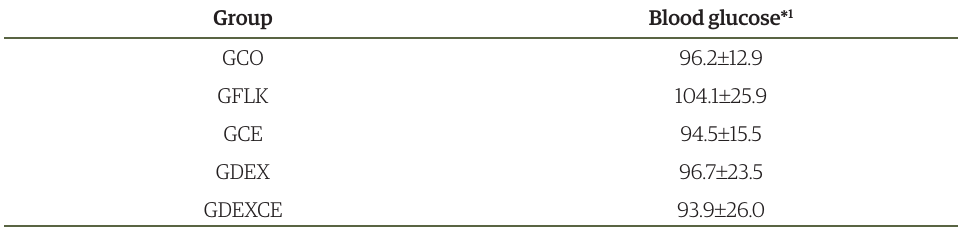
Table 6. Blood glucose values (mg/dL) in the groups.